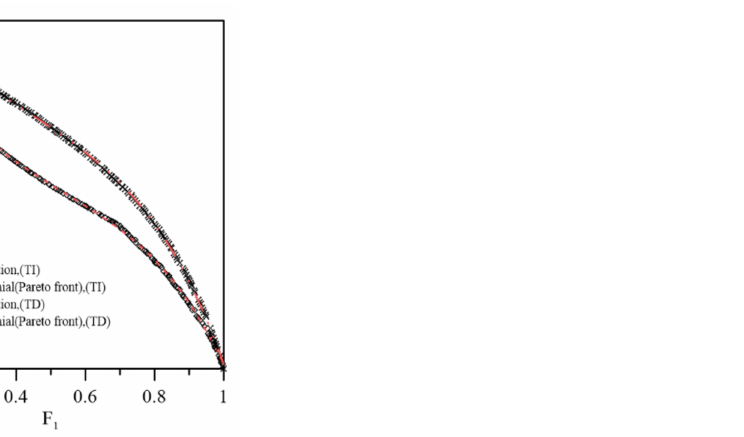
Figure 9. Curve fitting for the Pareto-optimal fronts for the cases of TI and TD material properties. Table 5. Pareto-optimal solutions for simply supported FG beams under a uniform temperature change sorted according to the F 2 function values from the largest to the smallest, in which temperature-independent material properties are considered. Order Number of Pareto-